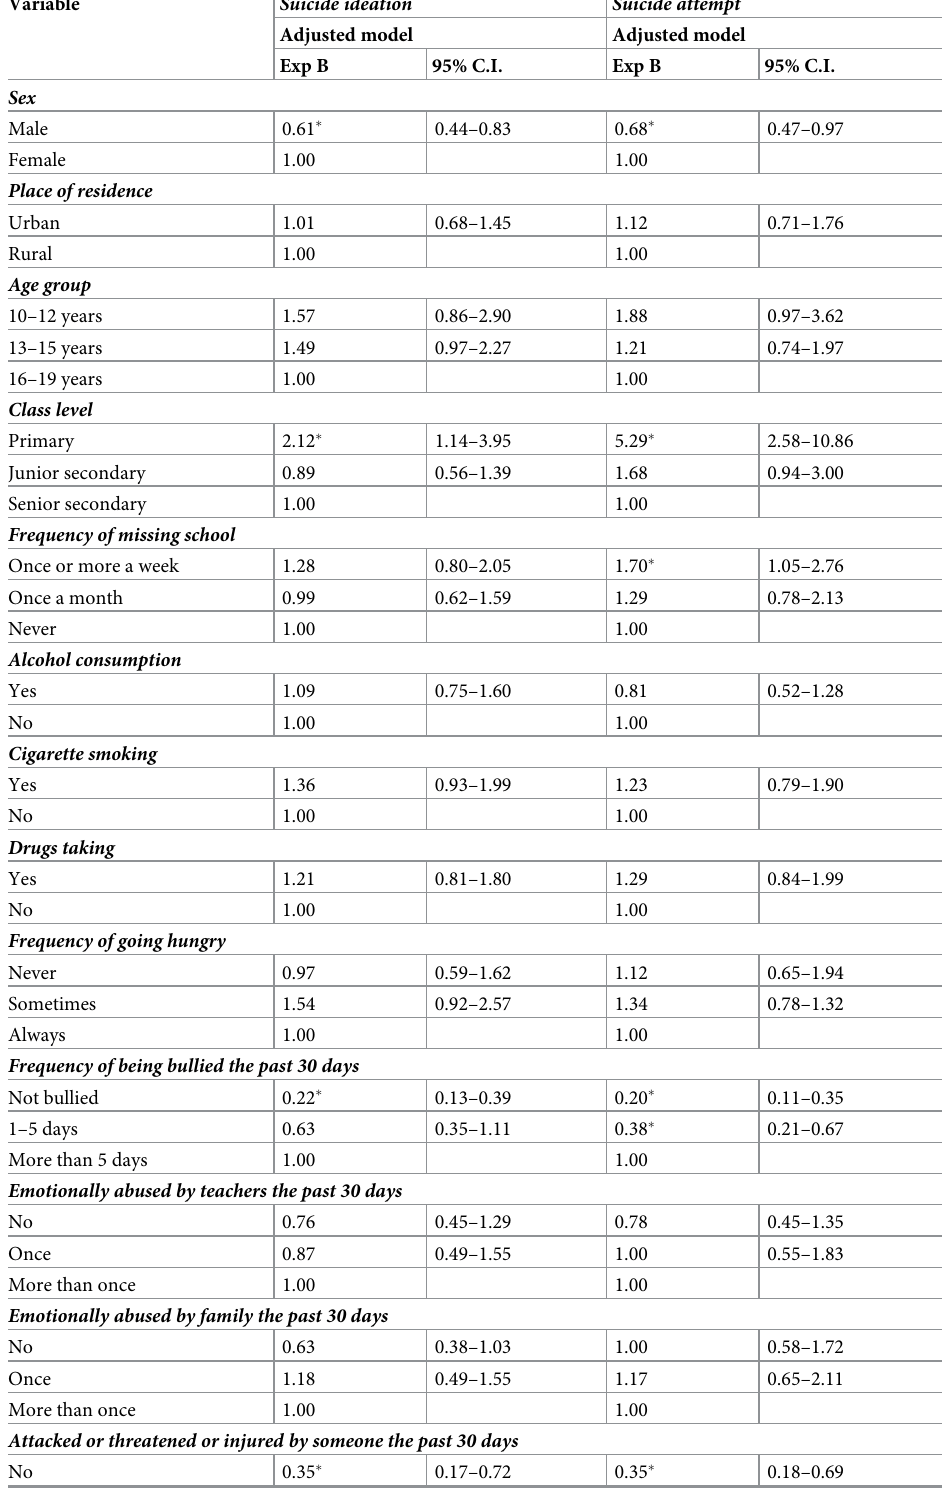
Table 3. Adjusted odds ratios showing the likelihood of suicide behaviours among learners aged 10–19